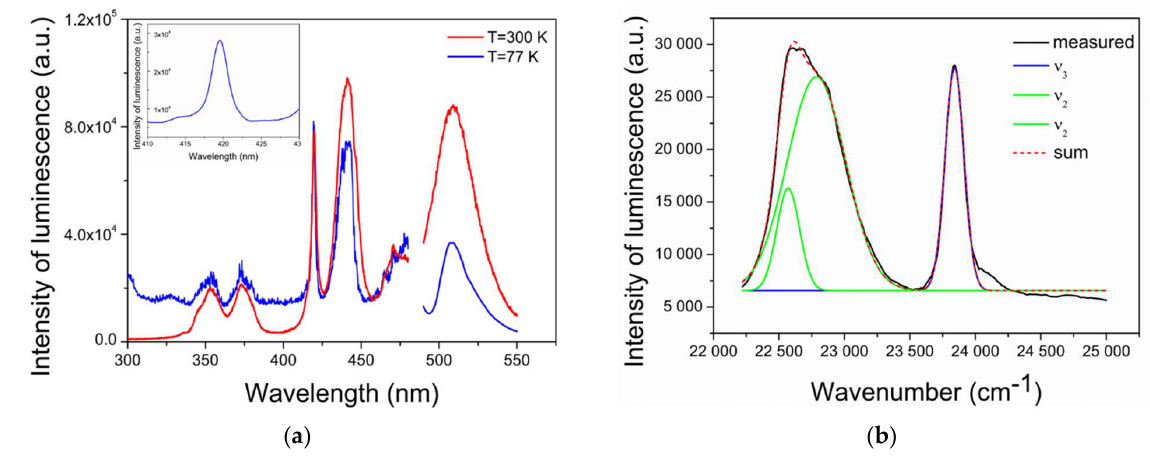
Figure 6. Luminescence spectra of Mn 2+ in genthelvite, ( a ) left—excitation spectrum, right—emission spectrum. Inset: the υ 3 excitation band measured at T = 77 K; ( b ) deconvolution of the 3 and 2 excitation bands measured at T = 77 K.